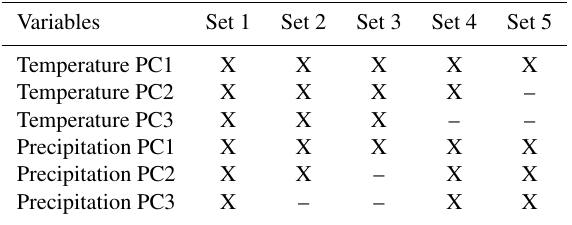
Table 1. Variables included in the five sets of predictors tested dur- ing model calibration. X indicates using a principal component (PC)